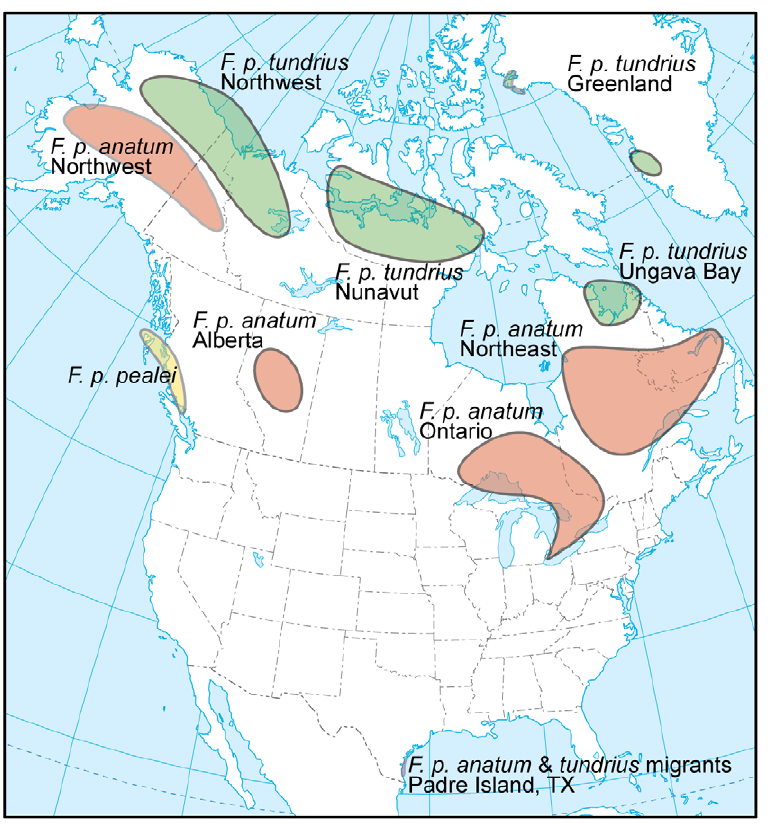
Figure 1. Peregrine falcon population sampling locations in North America. Samples sizes for each area are given in Table 1.